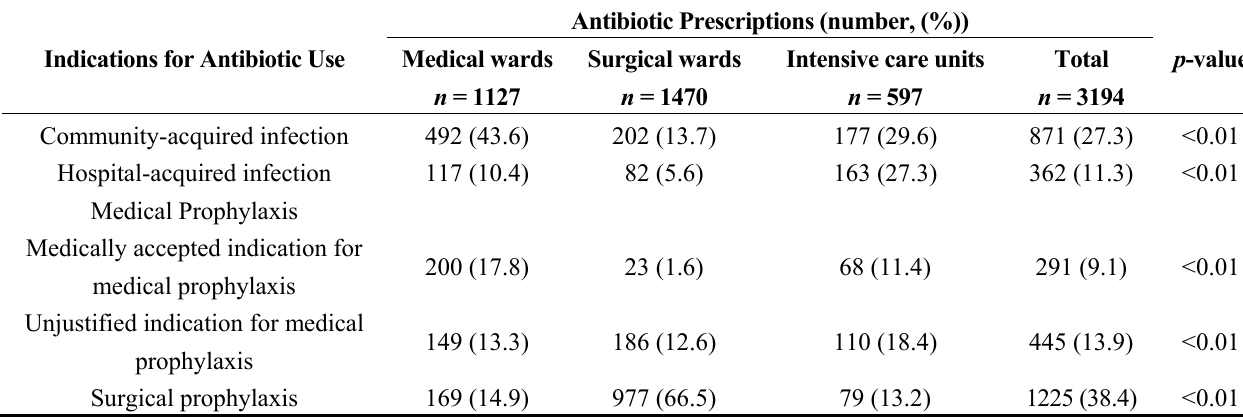
Table 2. Indications for Antibiotic Use Stratified by Type of Hospital Ward.